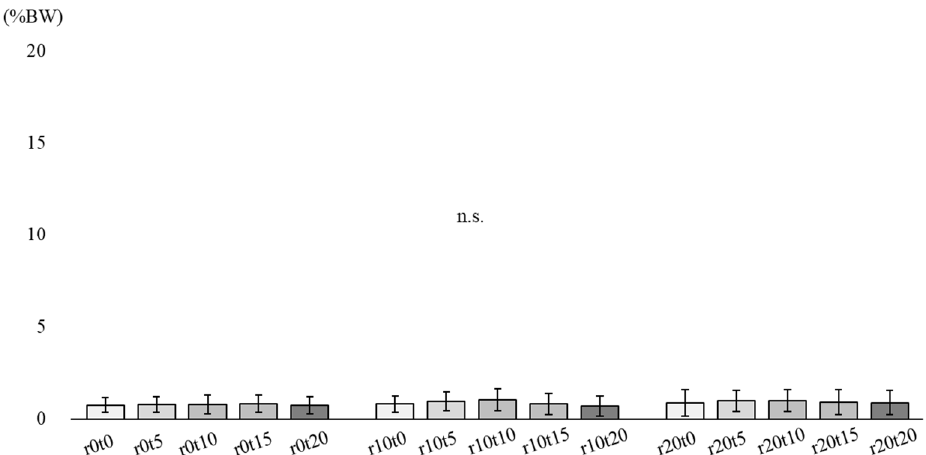
Figure 4. Lateral component of the shear force. R: reclining, t: tilt-in-space, n.s.: non-significant.